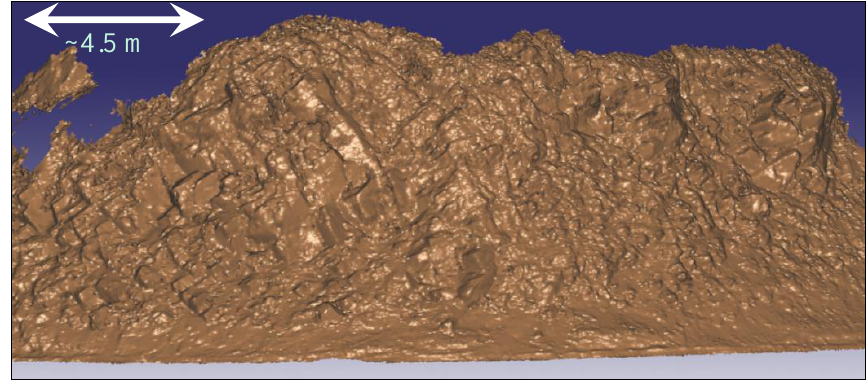
Figure 7. Photograph of rock slope study Site A showing three well-defined discontinuity sets.